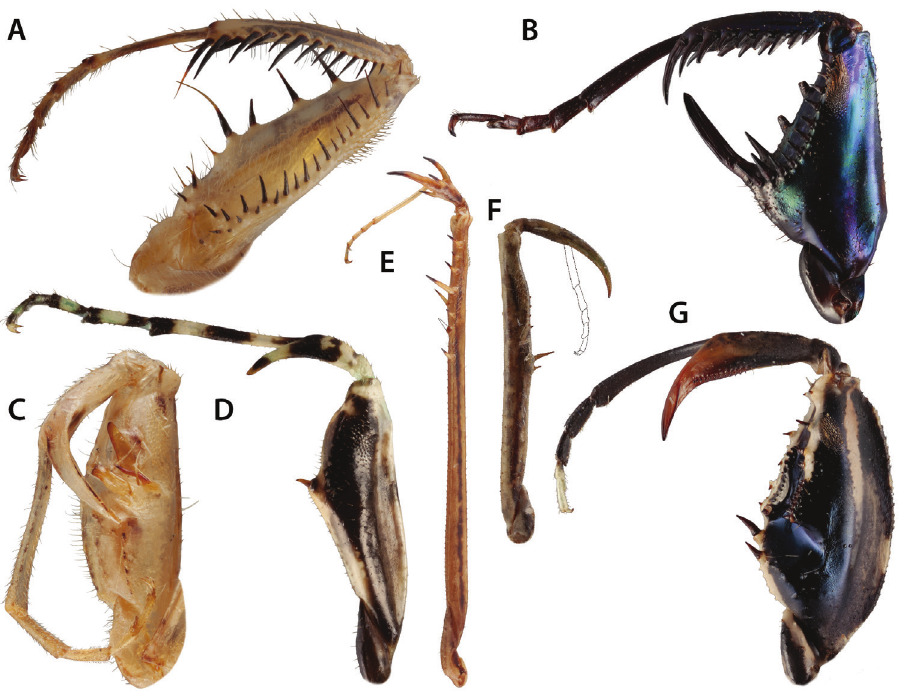
Figure 7. Figure 7. Foreleg spination variation across Mantodea presented in anteroventral view. A Chaeteessa sp. ♂ B Metallyticus splendidus ♀ C Paramorphoscelis gondokorensis ♀ D Amorphoscelis pulchella Giglio-Tos, 1914 ♀ E Thesprotia sp. ♂ F Compsothespis sp. ♀ G Paraoxypilus sp. ♀ . Dashed outlines indicate relative position of broken foreleg structures (i.e., spine E and tarsus F ). Forelegs not to scale.